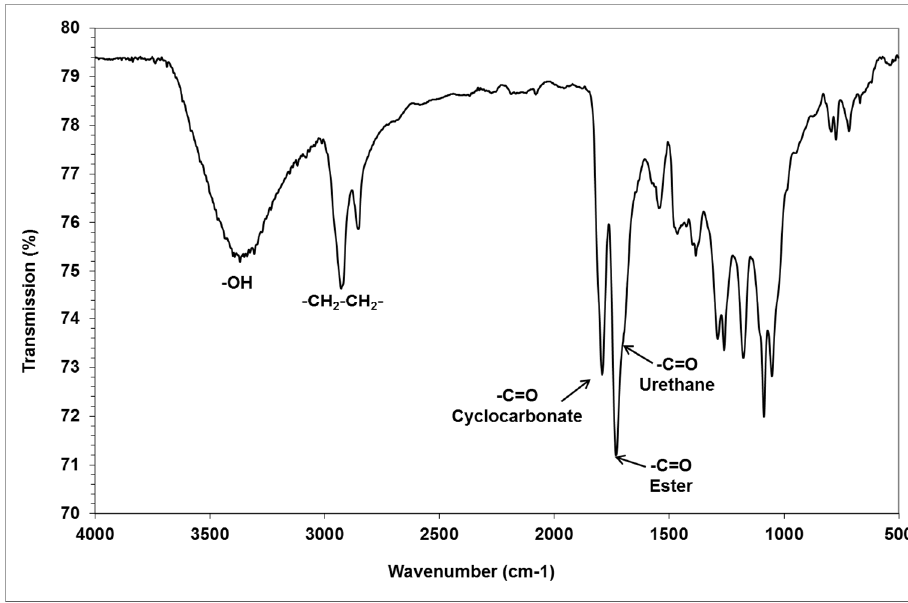
Figure 4. Infrared spectrum of a glycerol amino ethylene ester PHU gel (trial 12).